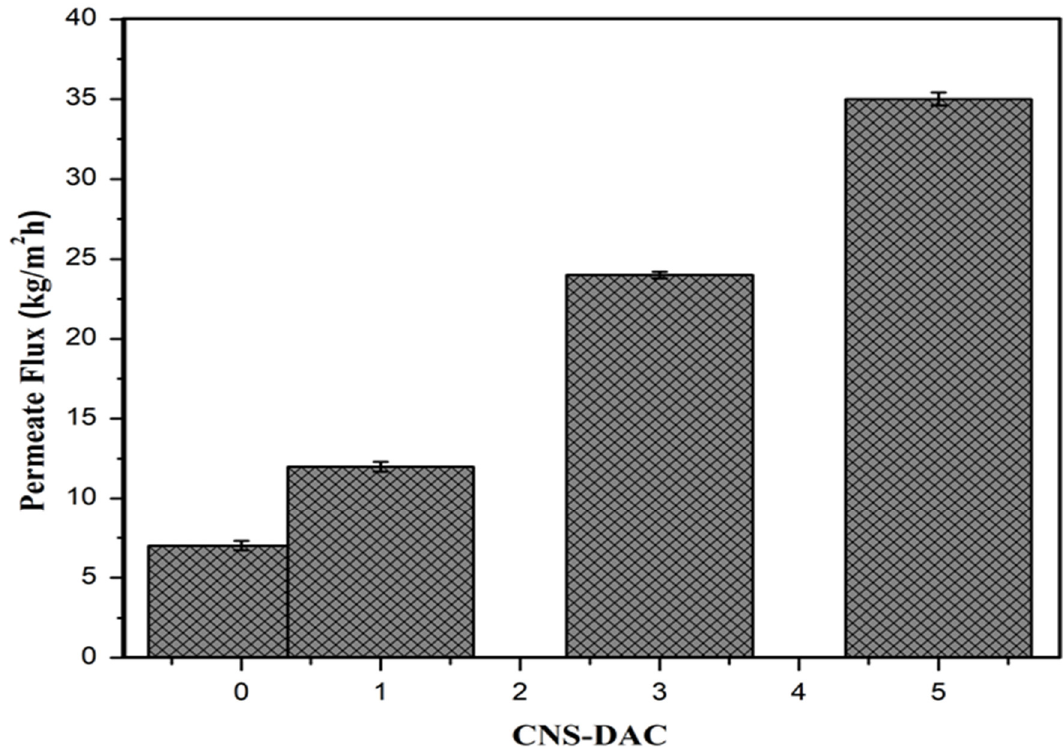
Figure 12. The effect of CNS loading on a permeate flux and MO removal